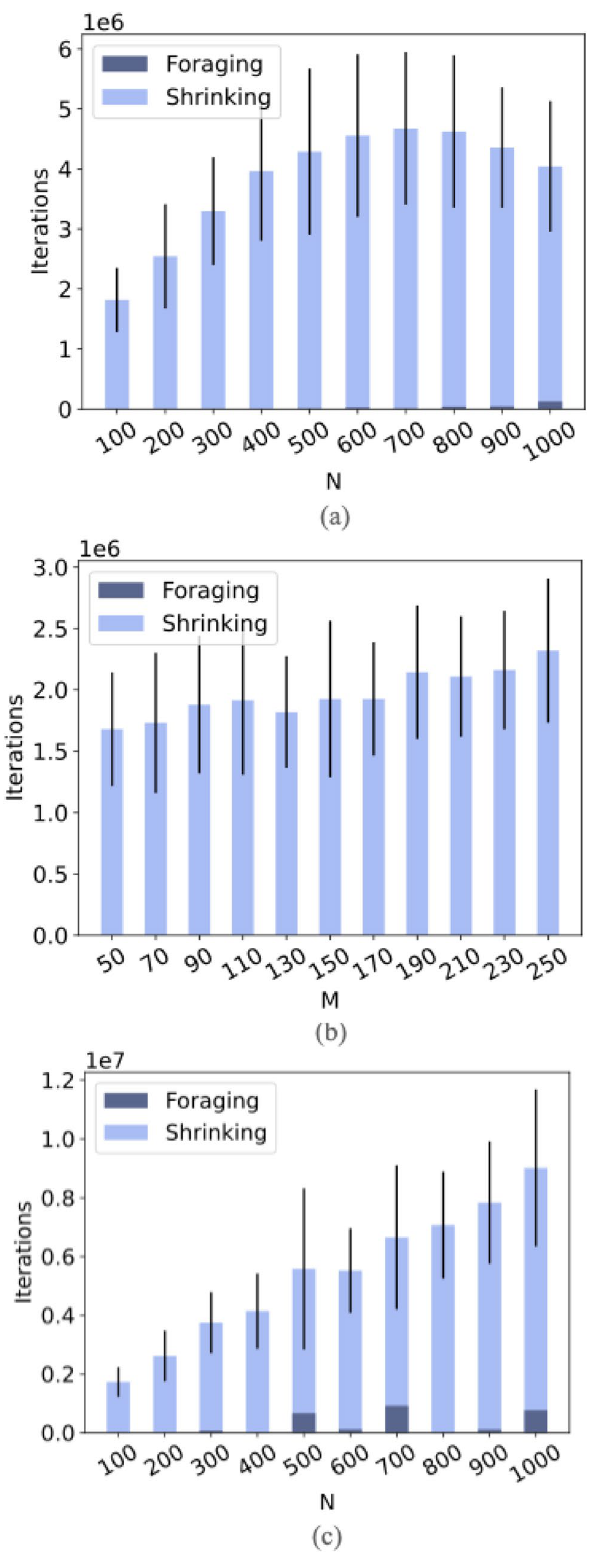
Figure 2. ( a ) Number of iterations varying with N . ( a ) Number of iterations varying with M . ( b ) Number of iterations varying with N normalized to 2 percent of M × M . ( c ) Black lines on bars represents error (standard deviation). Failed trials excluded from graphs